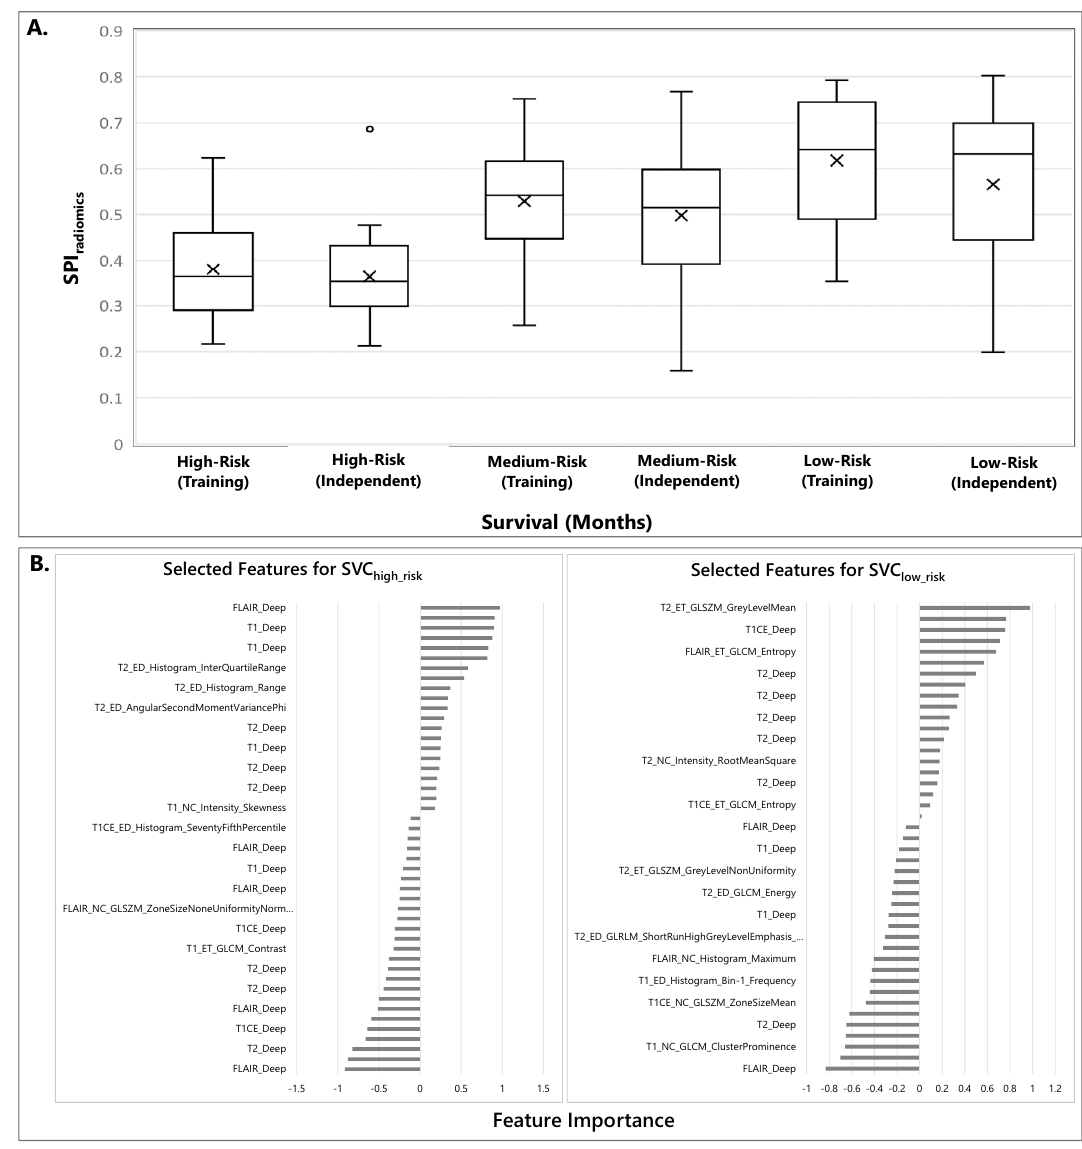
Figure 3. ( A ) SPI radiomics versus survival for high-risk (< 6 months), medium-risk (≥ 6, < 18 months), and low- risk (≥ 18 months) patient groups for the training and independent cohorts. Survival was maximum amongst the patients classified as the long survivors or low-risk, minimum amongst those classified to be short survivors or high-risk. ( B ) The selected features (n = 47) for the high-risk classifier, i.e., SVC high_risk (left), and the selected features (n = 44) for the low-risk classifier, i.e., SVC low_risk (right). The y-axis in this plot represents the selected features and the x-axis denotes the importance of features in the The genomic variables were penalized using LASSO method in a Cox-PH model including genomic mutations and the selected genes were EGFR , MET , NOTCH2 , PDGFRA , and RB1 . The Cox-PH model including clinical, MGMT methylation status, and genomic variables showed a c-index of 0.70 (95% CI 0.66–0.75), performing simi- larly to the model composed of clinical and SPI radiomics covariates. Significant predictors of OS in this model were patient’s EOR (HR = 0.35, 95% CI 0.22–0.54; p < 0.0001), Age (HR = 1.03, 95% CI 1.01–1.05; p = 0.002), MGMT methylation status (HR = 0.53, 95% CI 0.34–0.81; p = 0.004), RB1 (HR = 0.38, 95% CI 0.19–0.76; p = 0.006), and